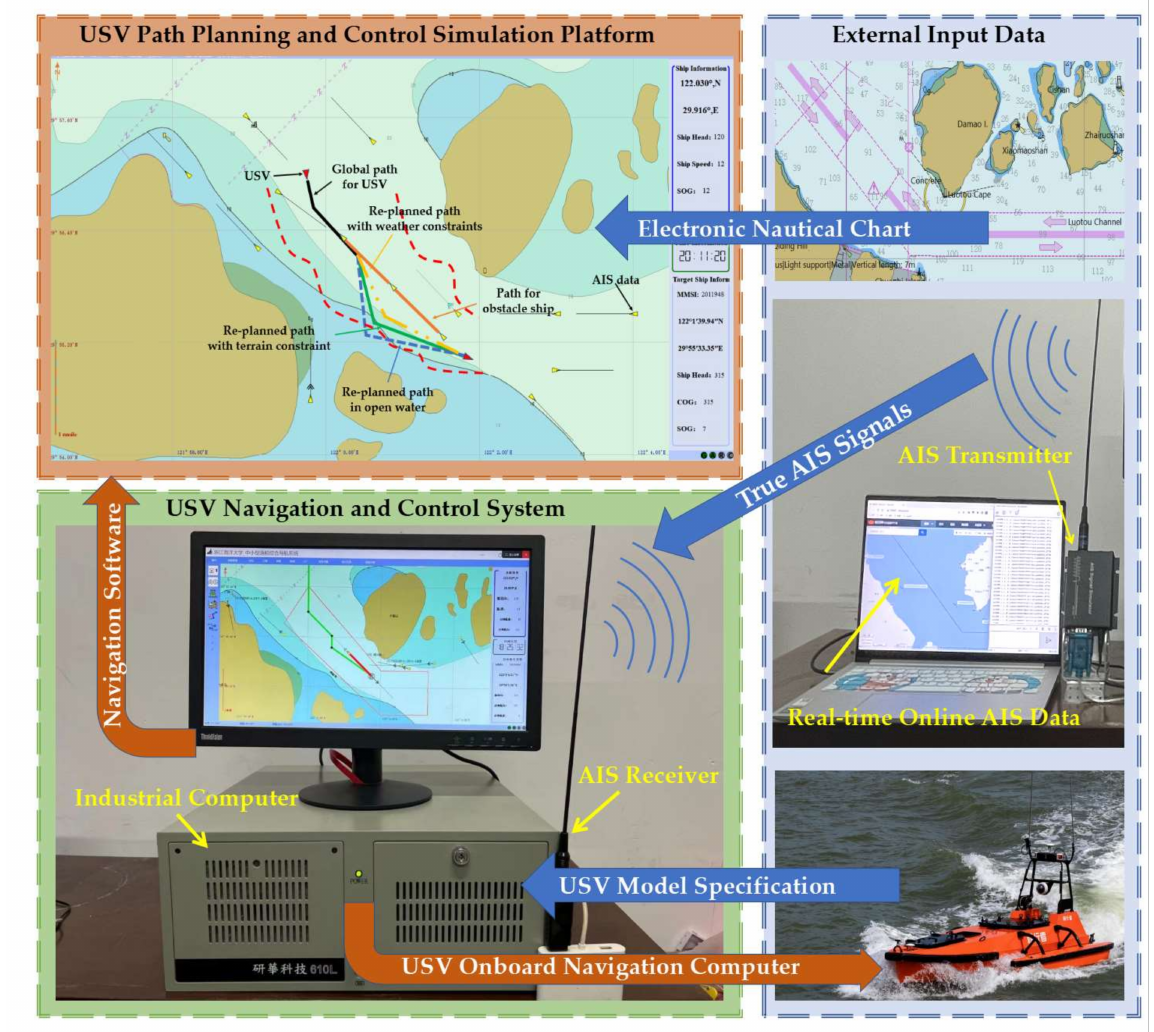
Figure 12. USV collision avoidance path planning HIL test